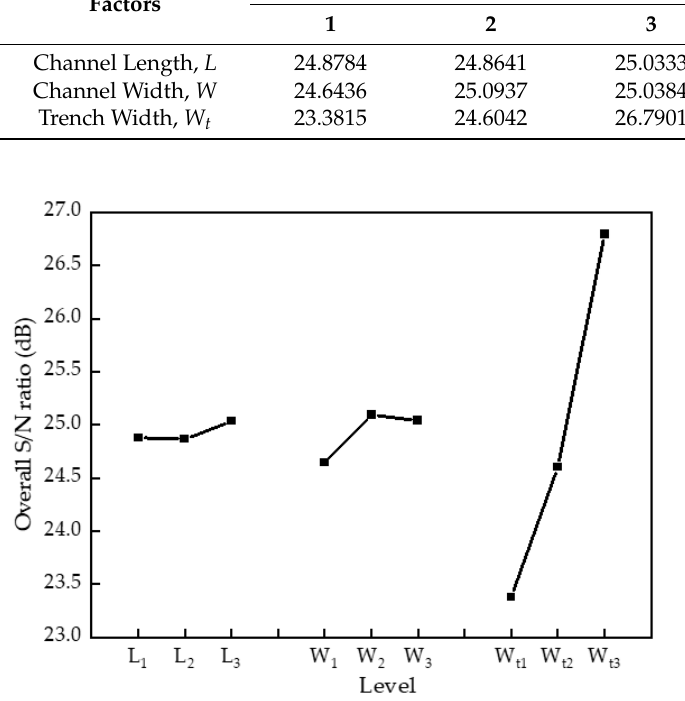
Figure 3. Overall S/N ratio for each control factor level.